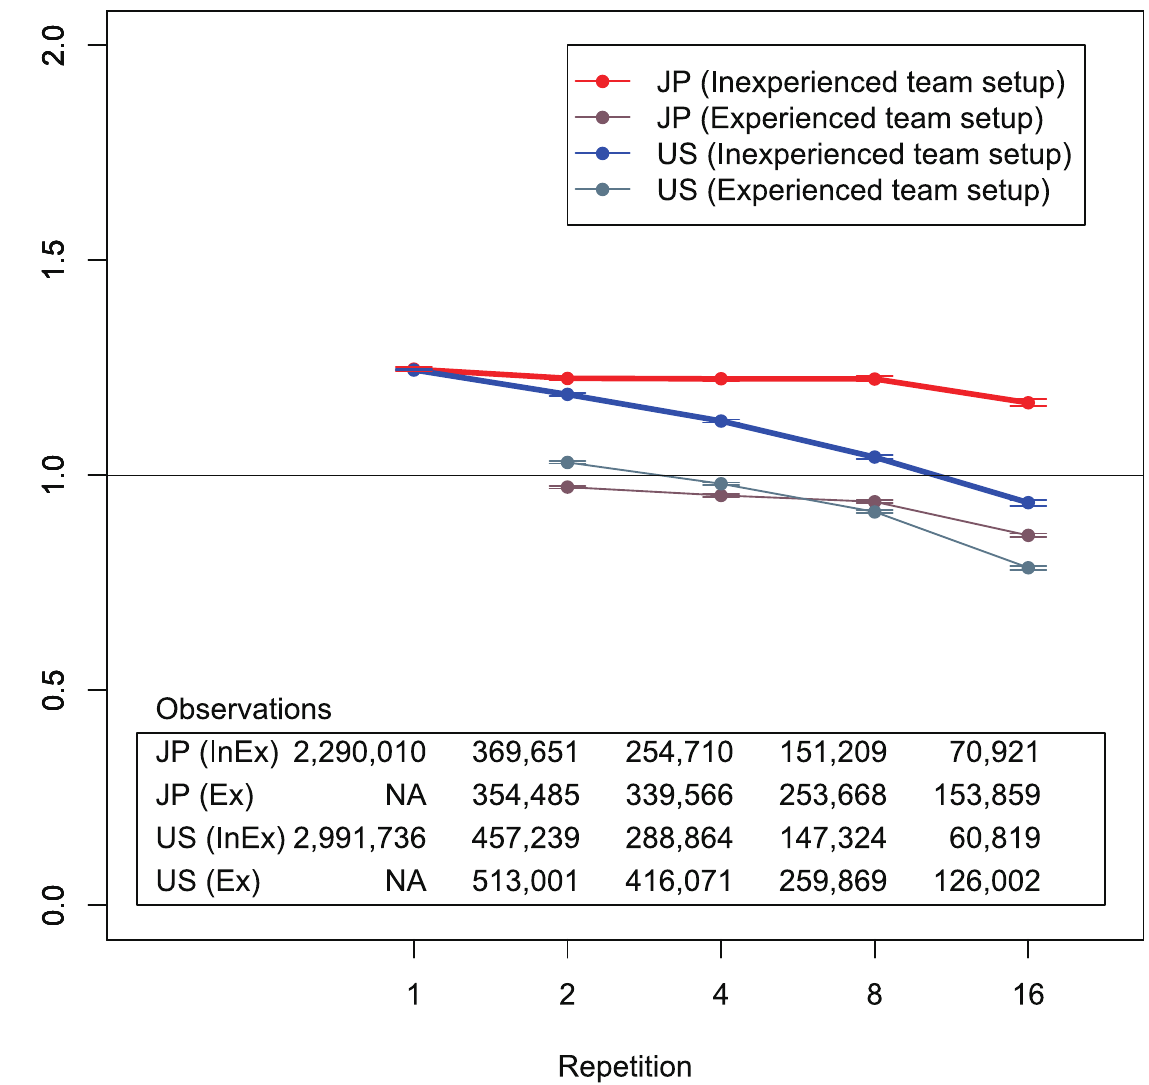
Fig 10. Average impact of repeat collaborations categorized by development of team members. Horizontal axis is repetitions by inventor pairs. Vertical axis is average impact. Brackets show standard errors. “ Inexperienced team setup ” (InEx) means some members other than target pairs enter or exit. “ Experienced team setup ” (Ex) means the opposite. Horizontal axis is cut so that number of samples is greater than approximately 100. Black horizontal line is impact =